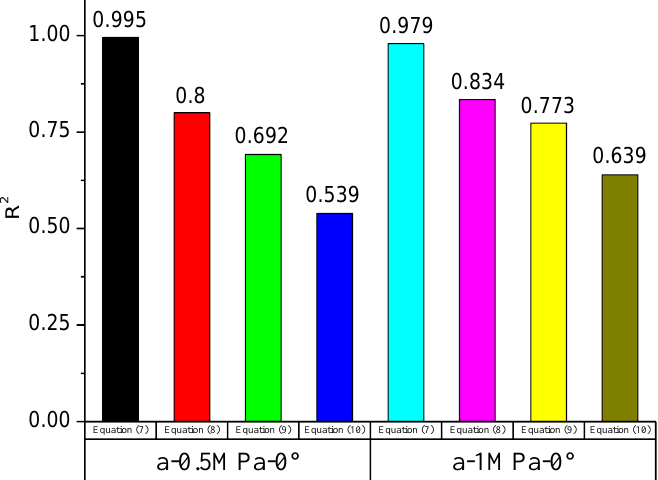
Figure 6. R 2 of each model.